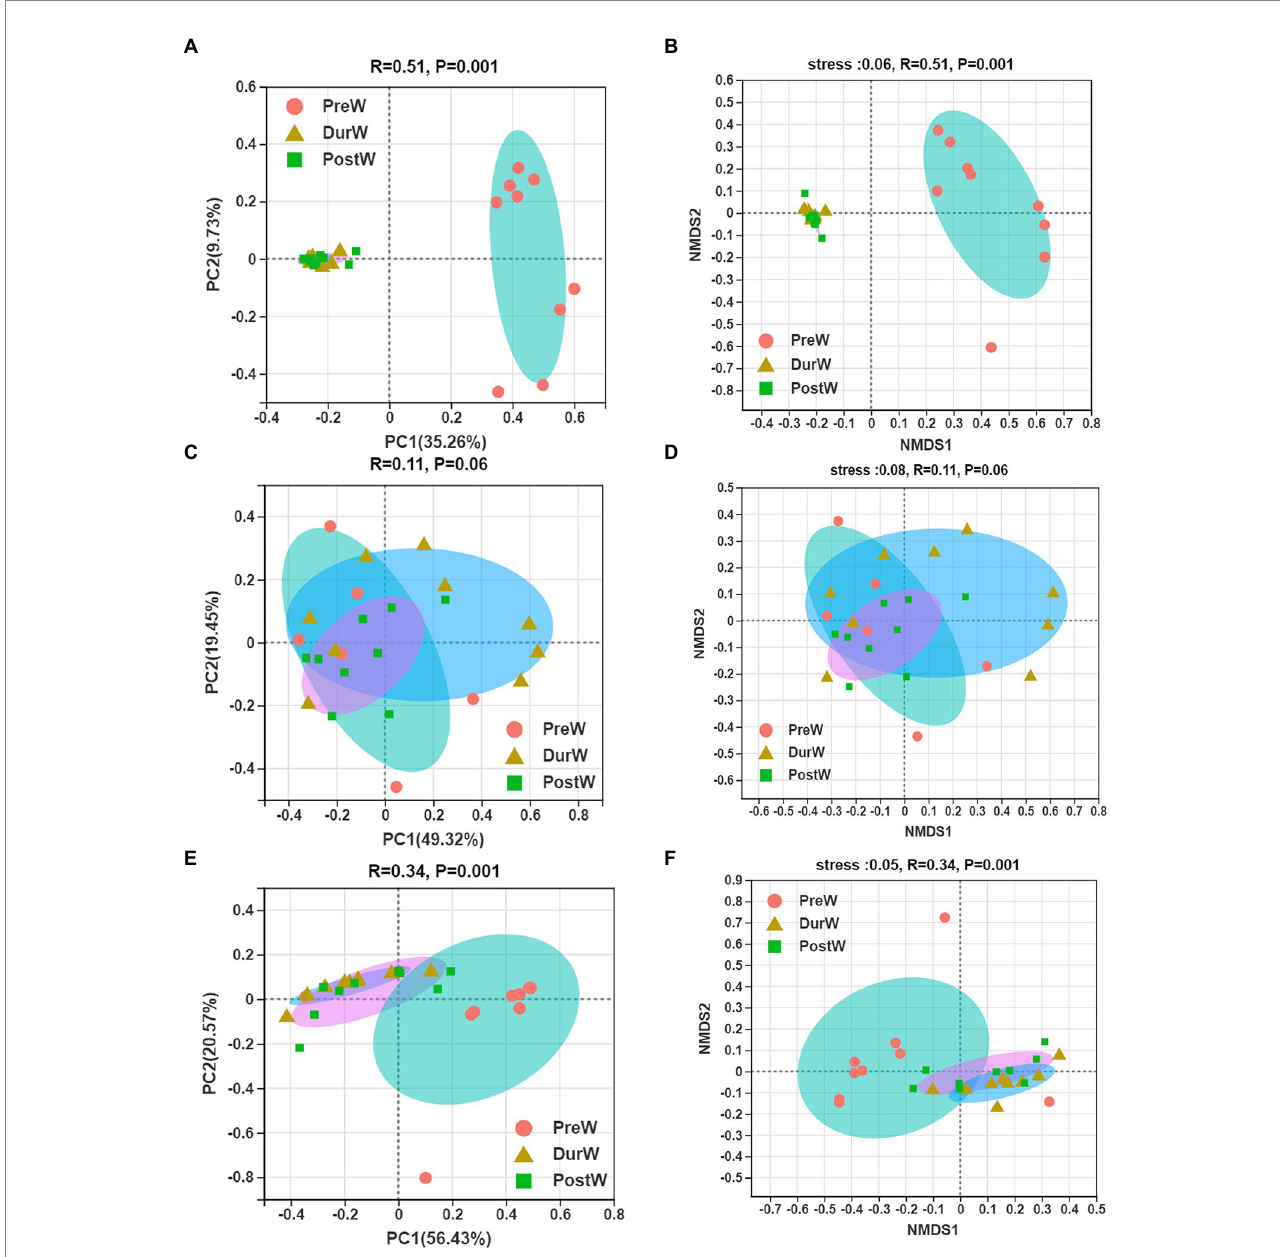
FIGURE 2 Principal co-ordinates analysis (PCoA) and Nonmetric multidimensional scaling analysis (NMDS) of microbial community composition among different groups. ( A) The PCoA analysis of bacteria. ( B) The NMDS analysis of bacteria. ( C) The PCoA analysis of anaerobic fungi. ( D) The NMDS analysis of anaerobic fungi. ( E) The PCoA analysis of archaea. ( F) The NMDS analysis of archaea; PreW, pre-weaning donkeys; DurW, during weaning donkeys; PostW, post-weaning